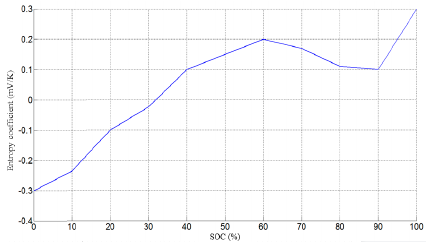
Figure 5. Entropy coefficient as a function of SOC.